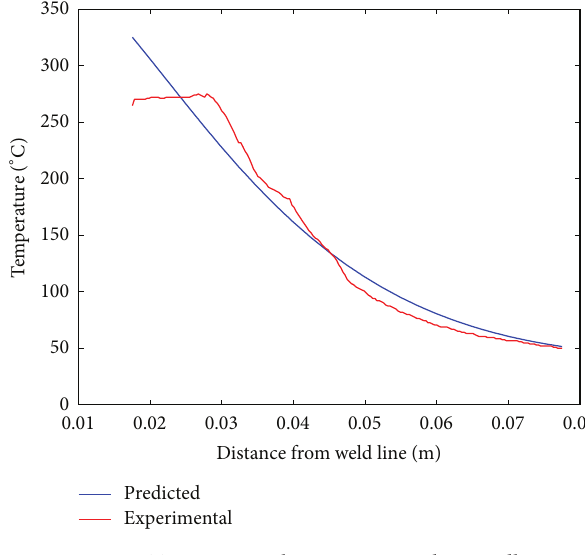
Figure 10: Temperature plot at 𝑡 = 55 sec along midline.